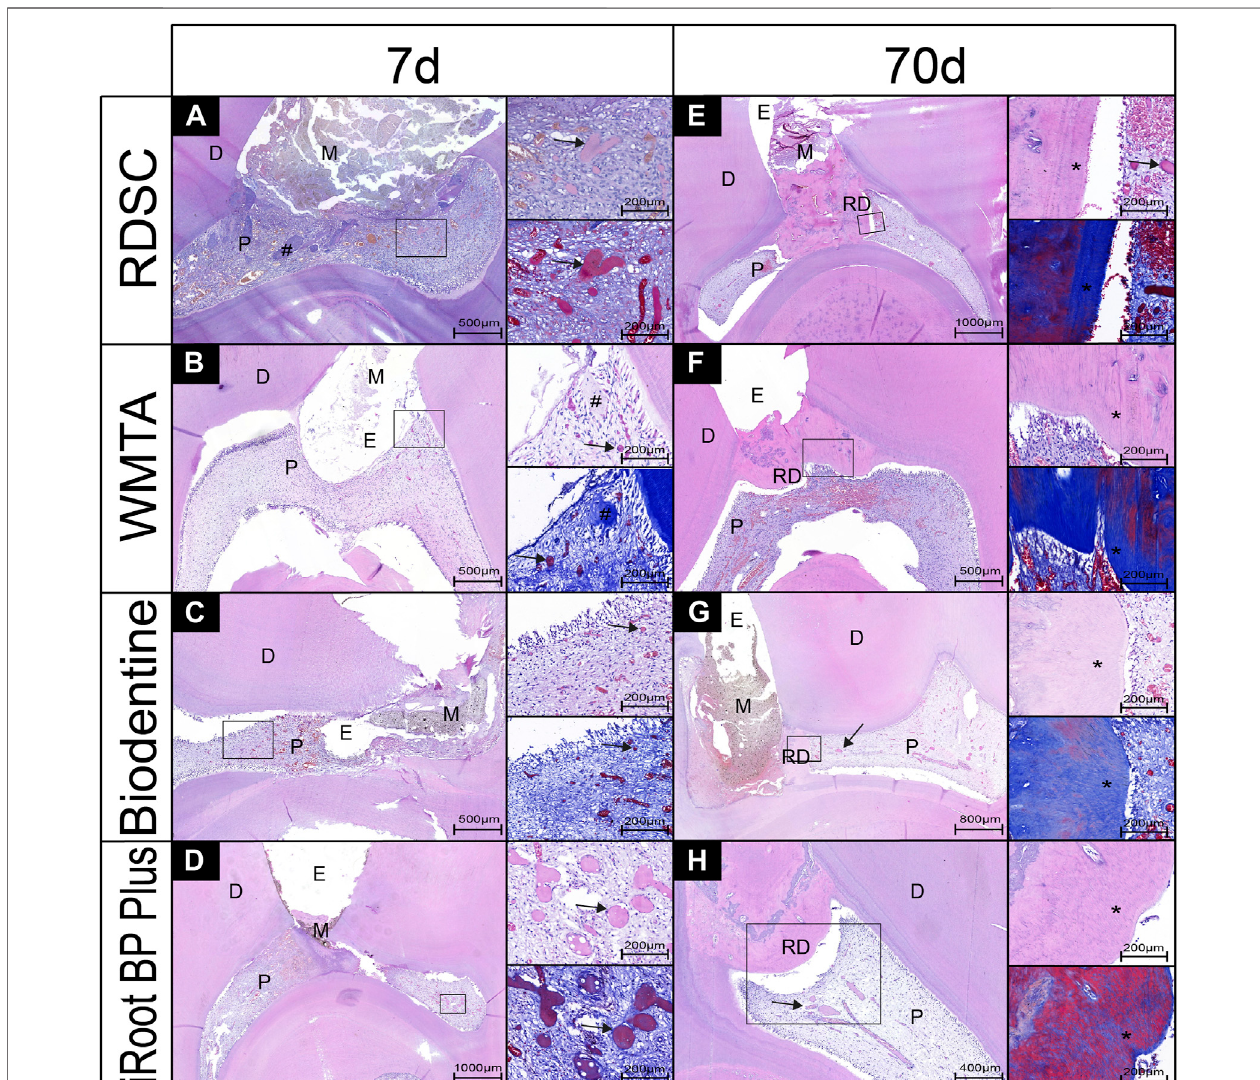
FIGURE 8| Pulp-tissue response of representative teeth after seven or 70 days in the in-vivo miniature pig model, with histological micrographs ofpulps that were capped by RDSC (A,E) , WMTA (B,F) , Biodentine (C,G) , iRoot BP Plus (D,H) . (D, dentin; M, materials; E, exposure sites; RD, reparative dentin; P, pulp tissue, arrows: mineral foci, #: collagen fi bers; *: tubular structures).